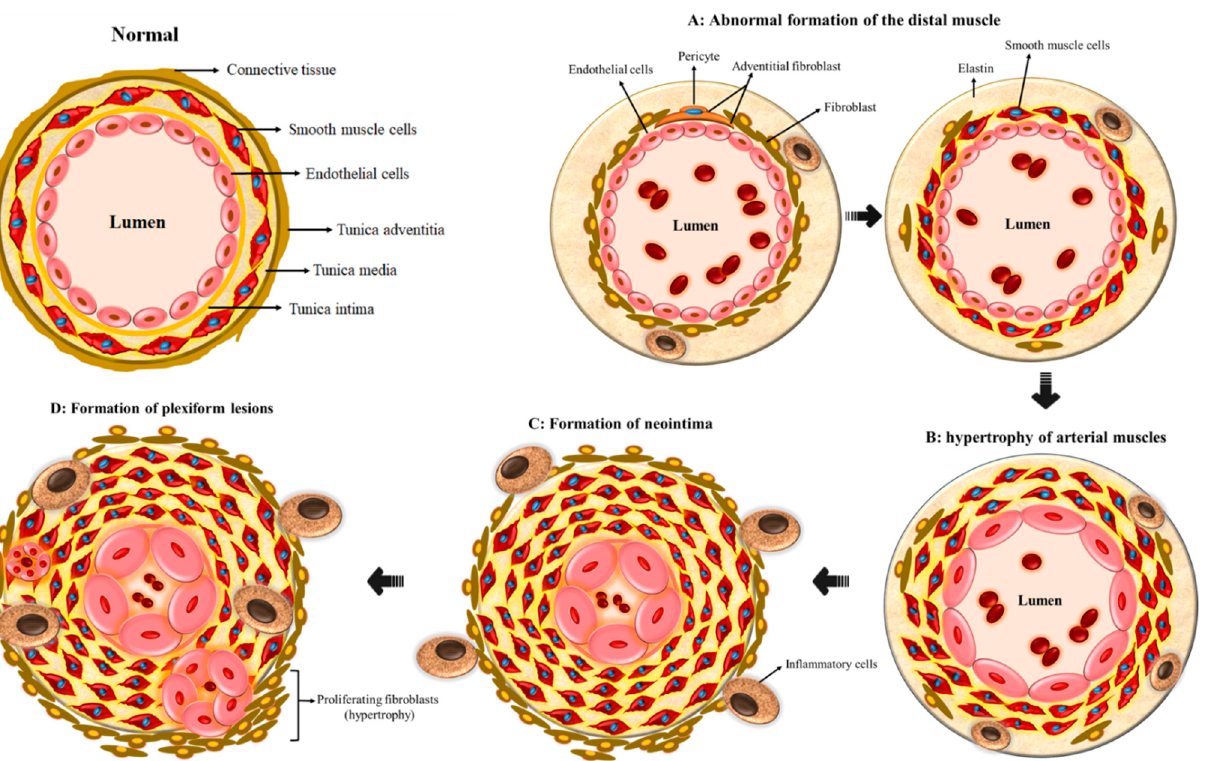
Figure 2. Schematic representation of pre-capillary arterieal remodeling in pulmonary arterial hypertension. ( A ) The condition commences with irregular distal muscle cell development trailed by ( B ) propagation of fibroblast and hypertrophy of the smooth muscle cells; ( C ) this primes the formation of neointima and plexiform lesions, subsequently leading to ( D ) constricted blood vessels that in turn increase the pulmonary blood pressure.